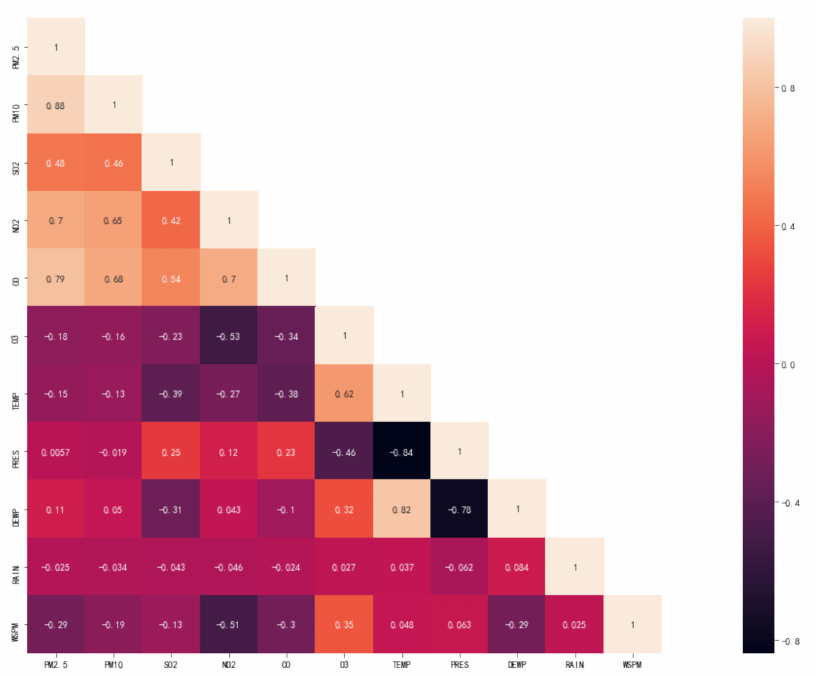
Figure 8. Thermal distribution diagram of correlation between air particulate matter, meteorological factors, and PM